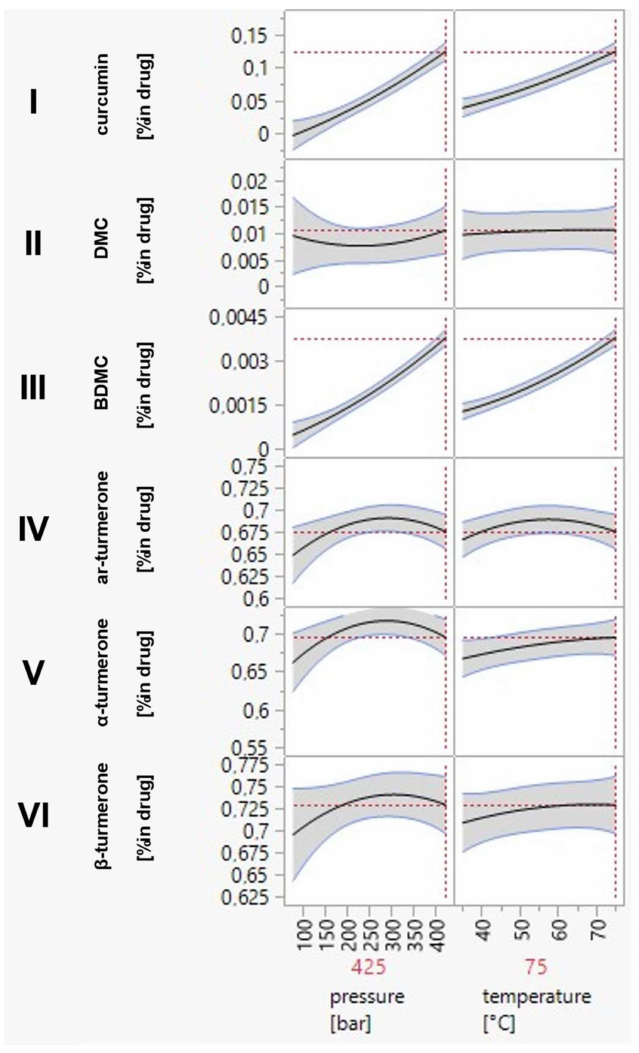
Figure 5. Prediction profiler diagrams with confidence intervals of a significance level of 0.05 show the separate influence of pressure and temperature on the recovery of all target compounds ((cur- cumin ( I ), demethoxycurcumin ( II ) (DMC), bisdemethoxycurcumin ( III ) (BDMC), ar-turmerone ( IV ), α -turmerone ( V ), β -turmerone ( VI )). The optimum extraction conditions for maximal compound recovery are marked with the red dotted lines: 425 bar and 75 ◦